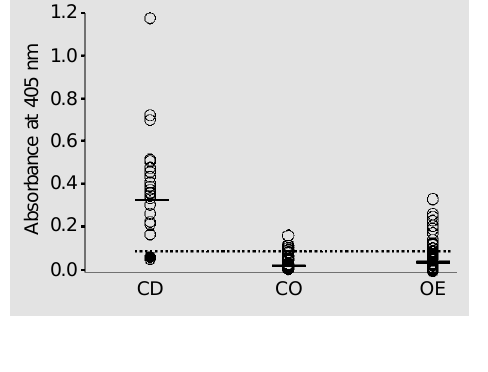
Figure 2. ELISA absorbance val- ues of antigliadin IgA antibodies in the celiac disease (CD, N = 22), control (CO, N = 46) and other enteropathy (OE, N = 61) groups. The dotted line repre- sents the cutoff value. The solid lines represent the mean of the absorbance values for each